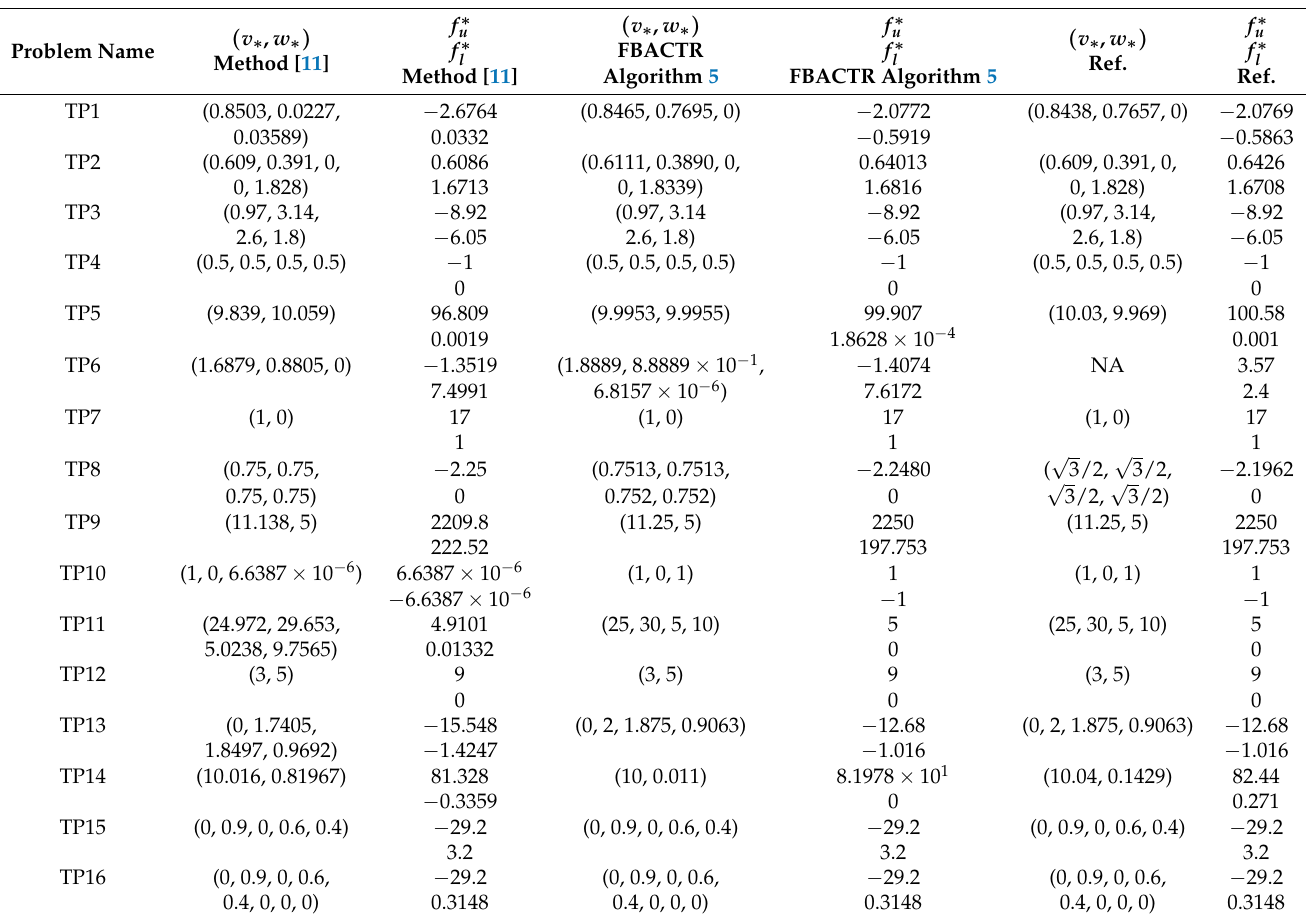
Table 1. Comparisons of the results of FBACTR Algorithm 5 with the method [11] and methods in the